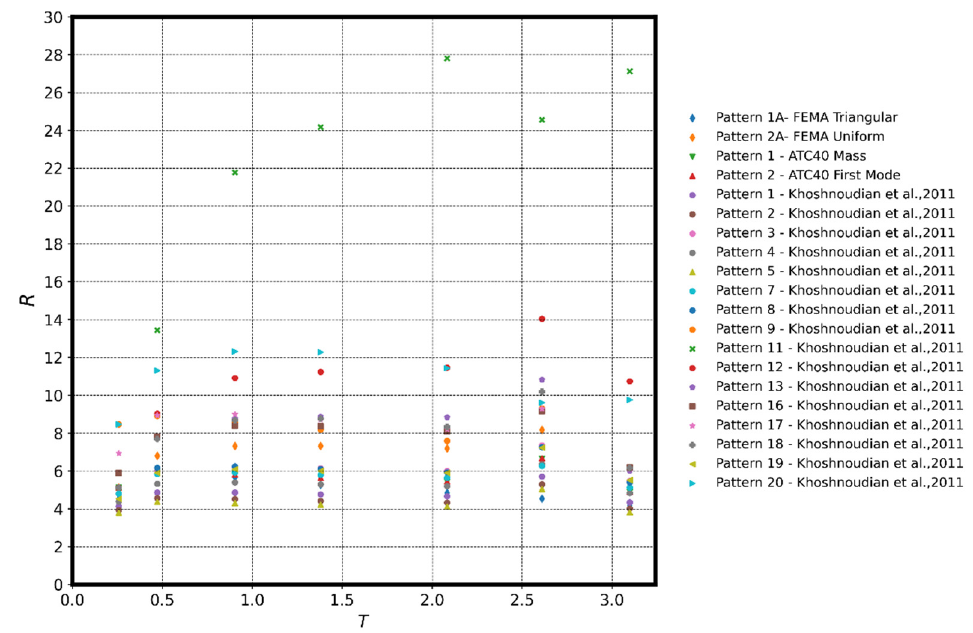
Figure 10. Strength reduction factor versus period for different patterns.